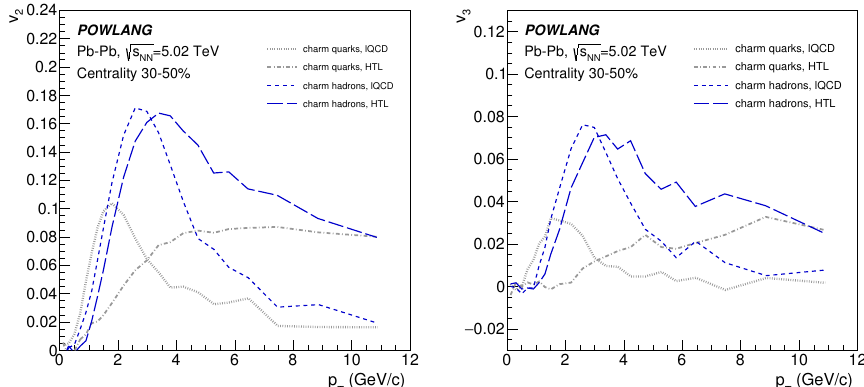
Figure 10 . The triangular (cid:13)ow of D 0 mesons in Pb-Pb collisions at ous centrality classes. The signal arises from event-by-event (cid:13)uctuations in the initial conditions. POWLANG predictions with HTL and l-QCD transport coe(cid:14)cients are compared to CMS data [7].